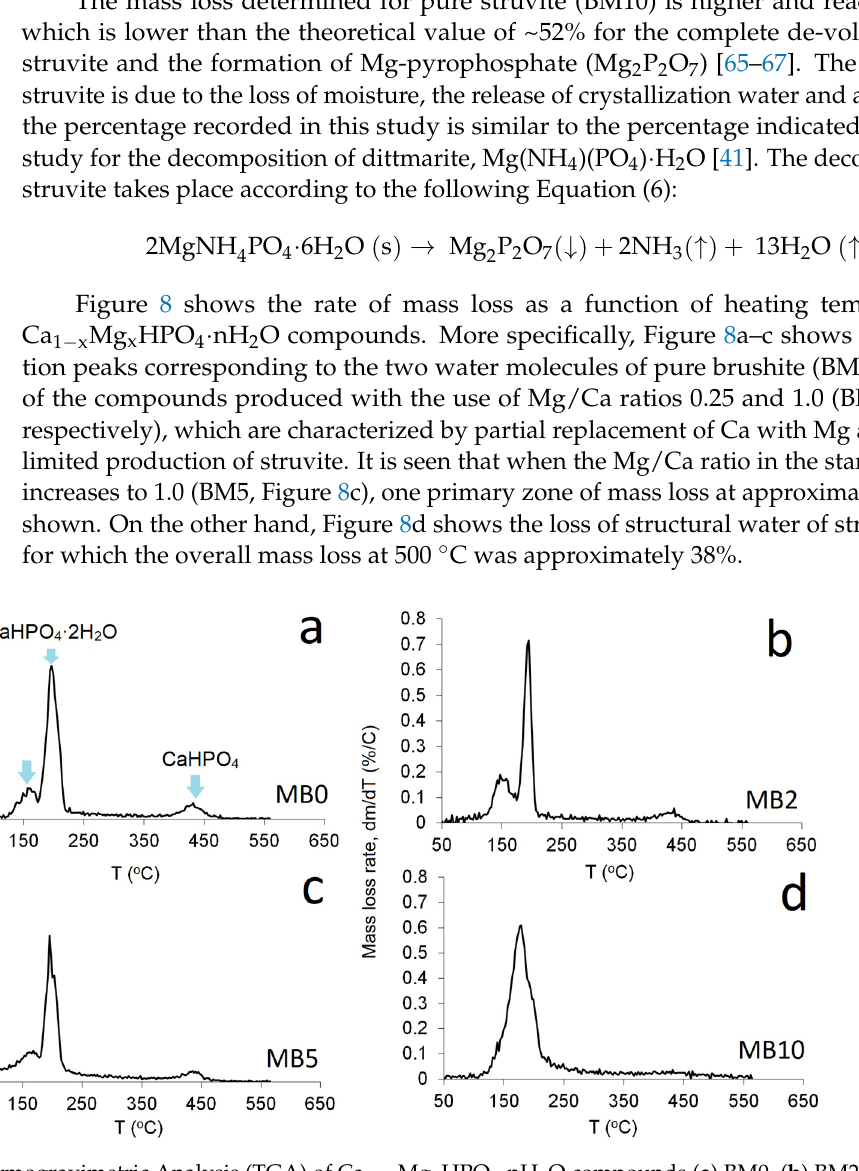
Figure 8. Differential Thermogravimetric Analysis (TGA) of Ca 1 − x Mg x HPO 4 · nH 2 O compounds ( a ) BM0, ( b ) BM2, ( c ) BM5, ( d ) BM10.